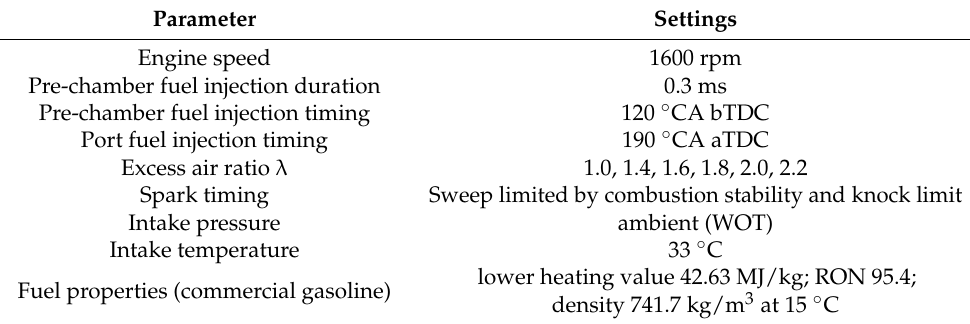
Table 2. Overview of operating